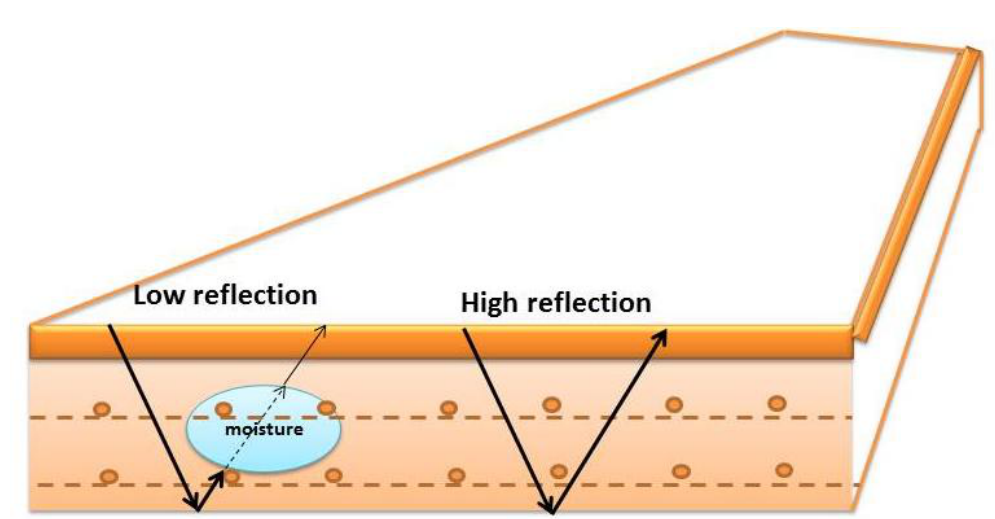
Figure 1. Reflection view of the